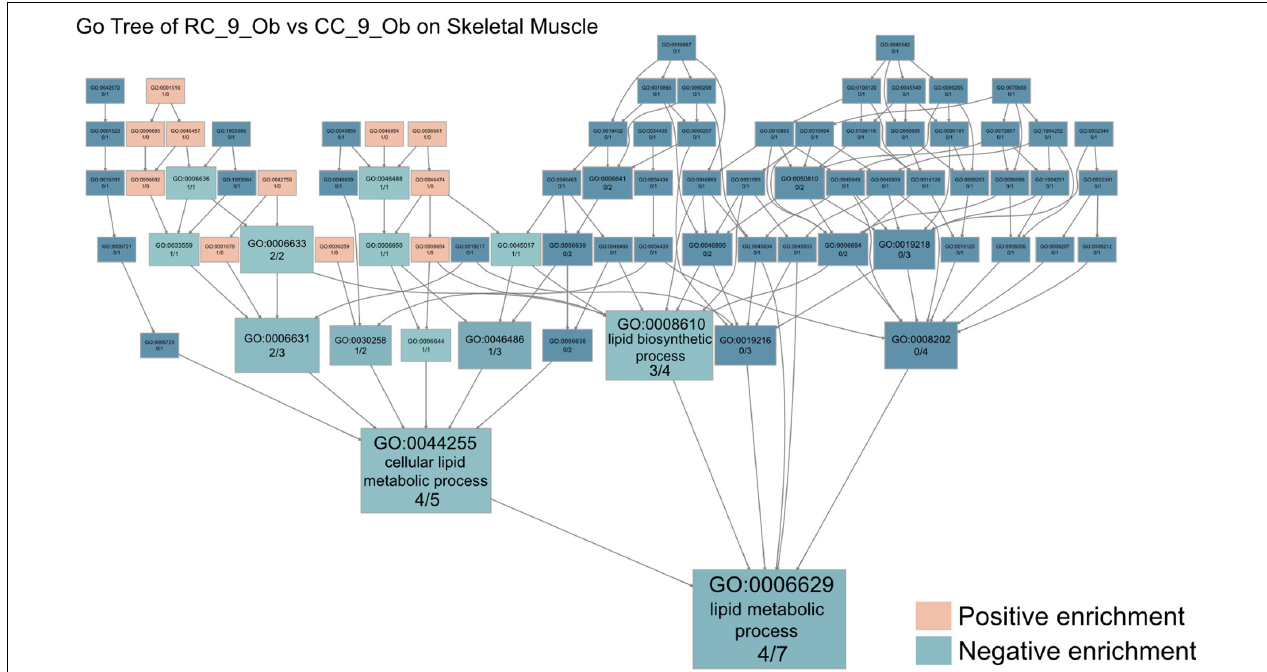
FIGURE 5 | IUGR impairs mitochondrial function in skeletal muscle. The GO tree of RC_9_Ob vs. CC_9_Ob on skeletal muscle. The box numbers represented the relative amount of DEG in the category. The box color equated to the numbers of upregulated and downregulated DEGs, with upregulated represented by pink and downregulated equaling blue, revealing impaired mitochondrial function in skeletal